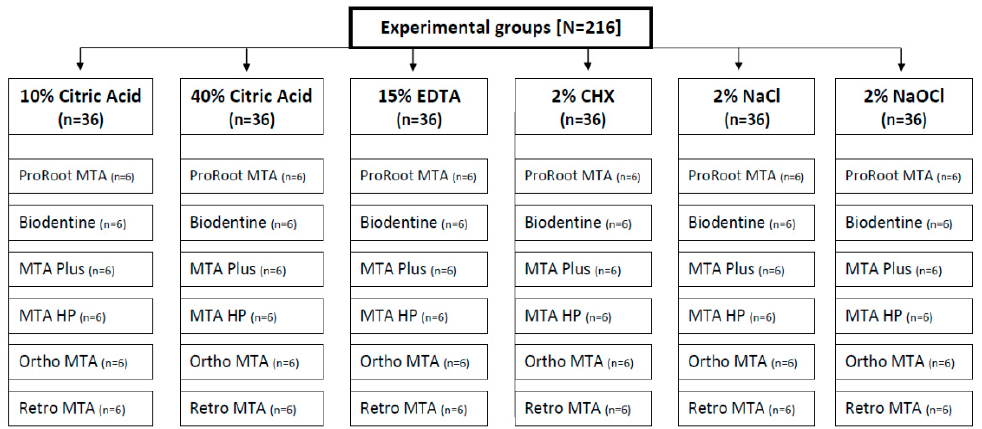
Figure 1. Description of experimental groups.